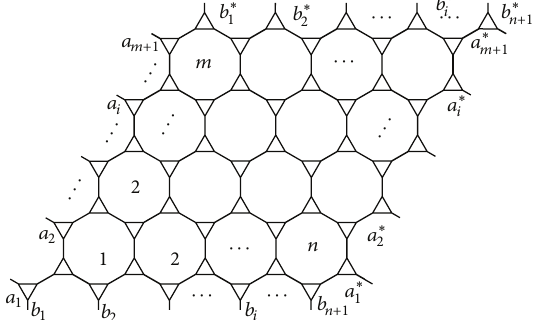
Figure 1: The 𝐽 𝑡 (𝑚,𝑛) lattice with toroidal boundary condition